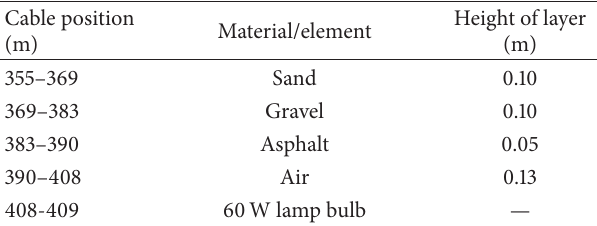
Table 1: Cable position, material, and height of layer (if